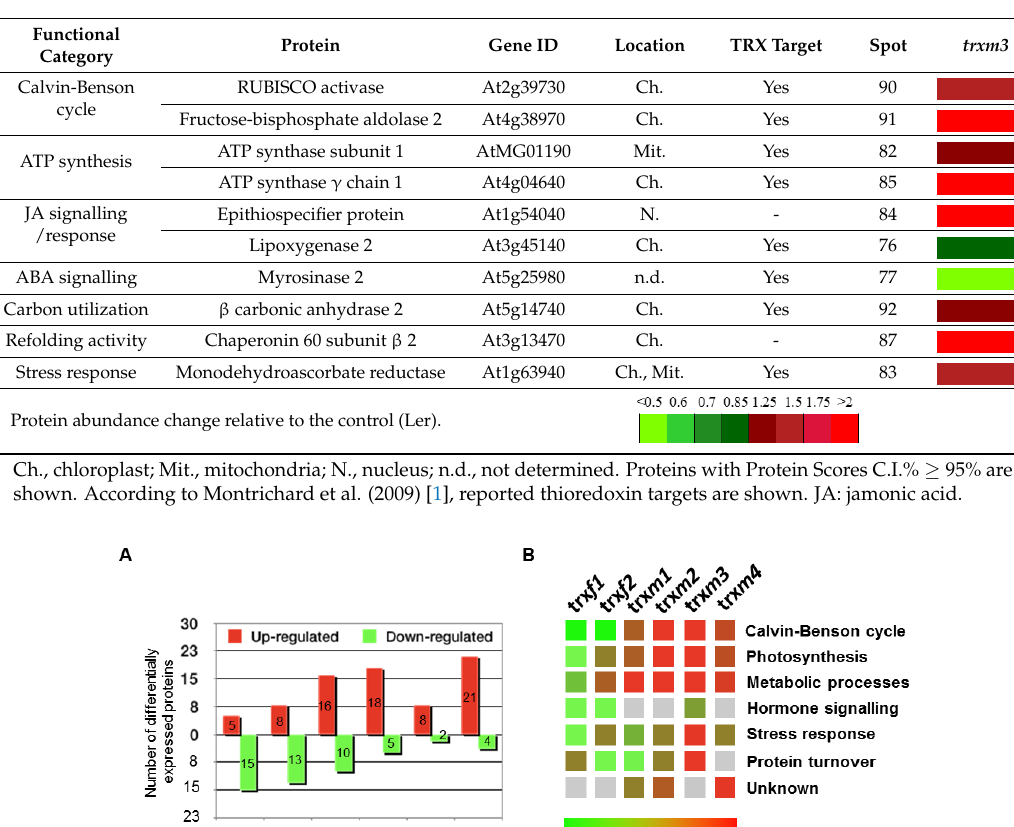
Table 3. Differentially expressed proteins identified by MS in the trxm3 mutant, organized in the functional category, the gene code and the subcellular localization and whether the protein has been reported as a TRX target. The color code indicates fold change in protein abundance.